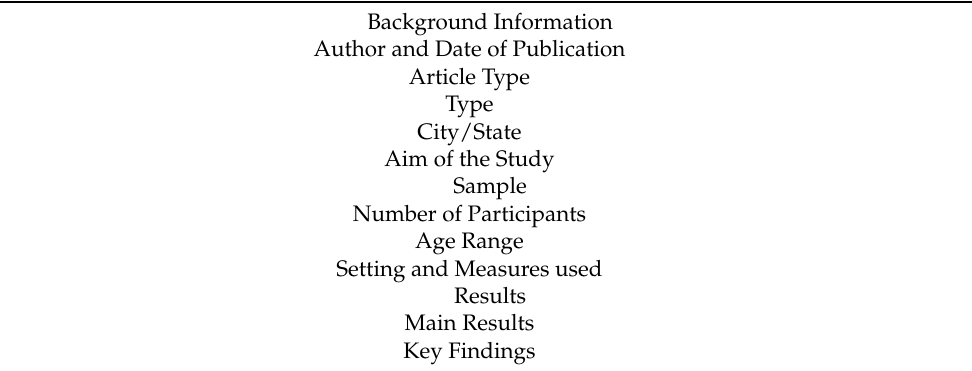
Table A1. Data Extraction